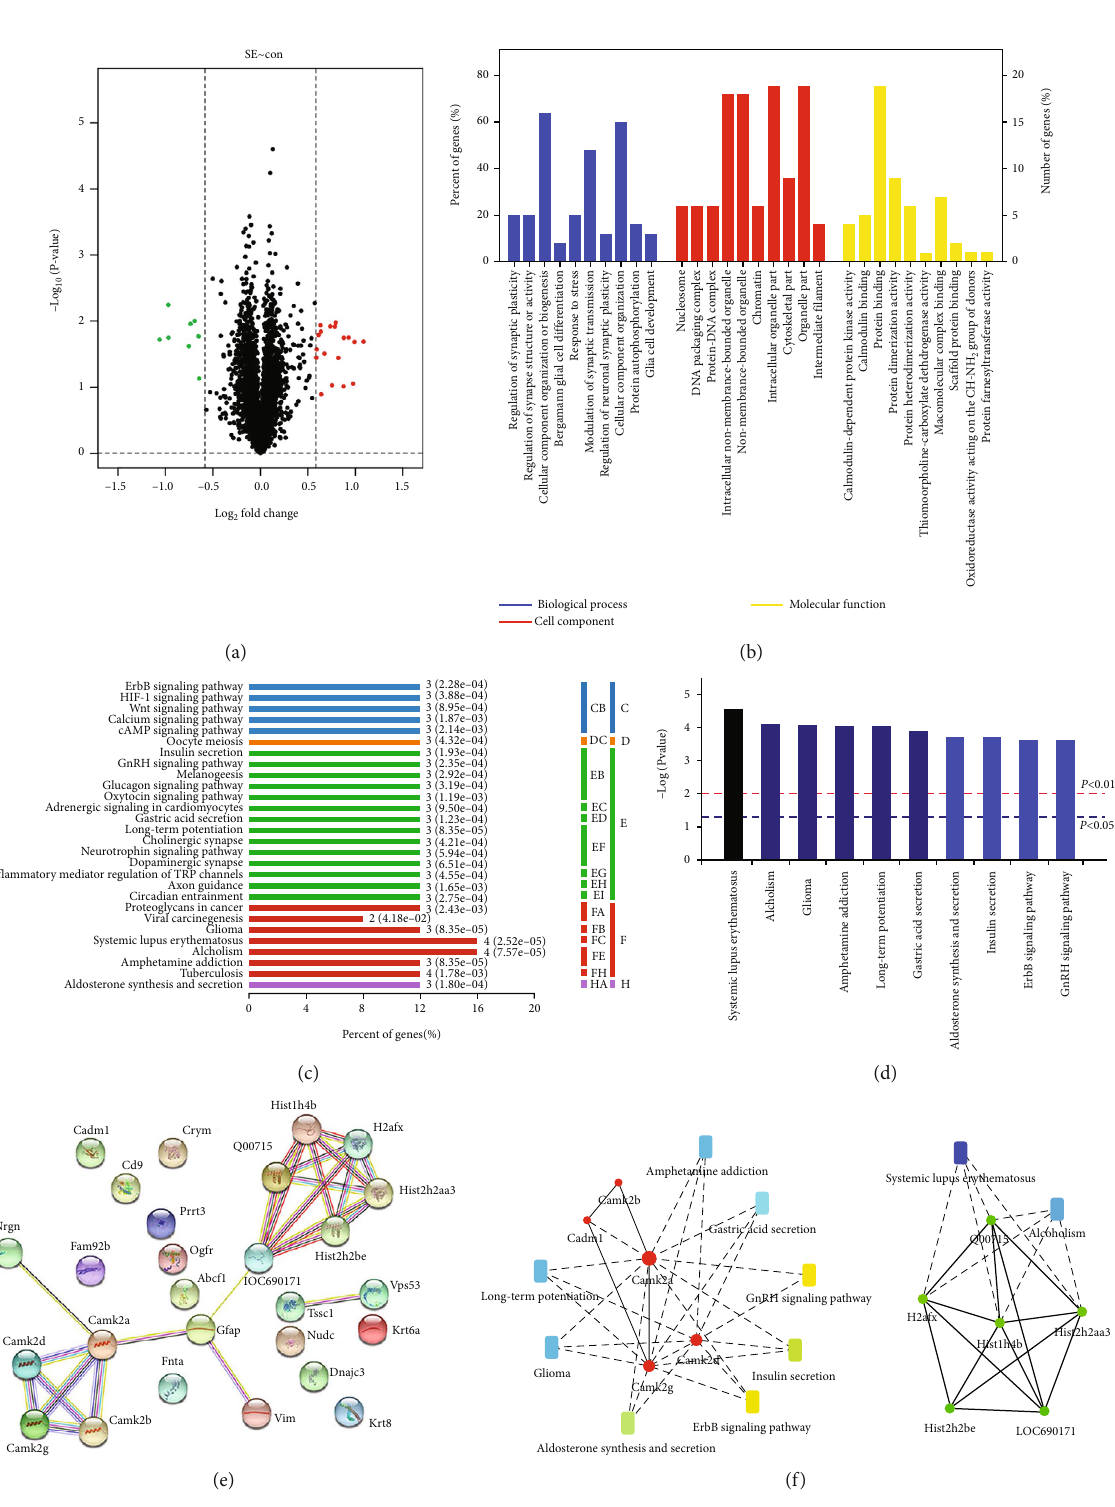
Figure 2: Bioinformatics analysis of hippocampus and functional annotation of DEPs. (a) Volcano plot of 4173 proteins. X -axis represents the fold change of DEPs (log 2), and the Y -axis indicates the P value ( − log 10). Red points and green points represent upregulated and downregulated proteins with signi fi cant di ff erence, respectively. (b – d) Functional annotation of 27 DEPs based on bioinformatics analysis. (b) The identi fi ed 27 DEPs were annotated into biological process, cellular component, and molecular function for GO term analysis. Entries in each category were listed according to P value ( P value increased gradually from left to right.); (c) the 28 pathways enriched by KEGG analysis on 27 DEPs. (d) the top 10 pathways with signi fi cant di ff erences by KEGG analysis; (e) protein-protein interaction network of 27 DEPs; (f) KEGG pathway-protein network